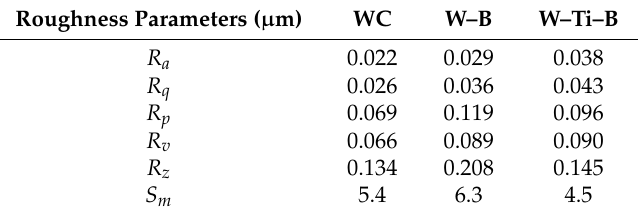
Table 2. Profile of roughness parameters, cut-off 0.25 mm.